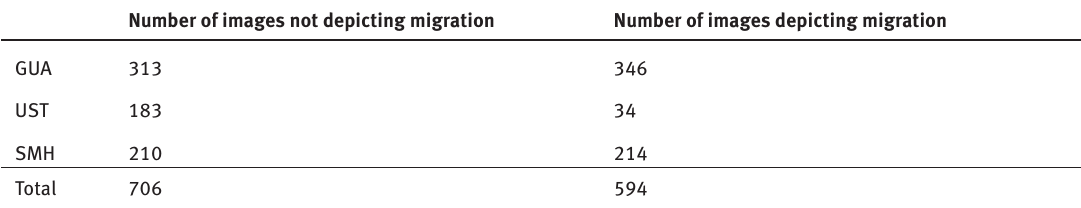
Table 3: Number of images depicting and not depicting migration